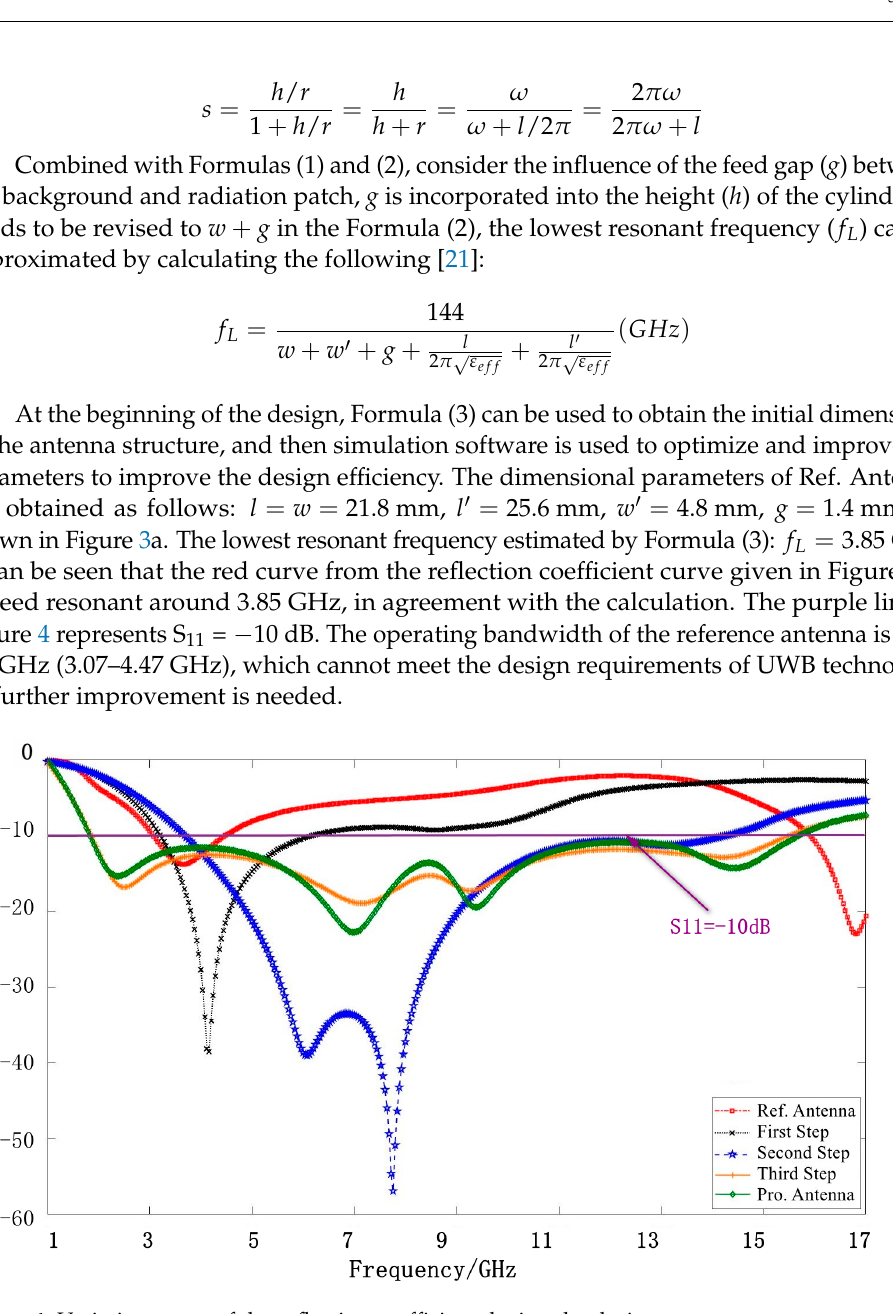
Figure 4. Variation curve of the reflection coefficient during the design process.